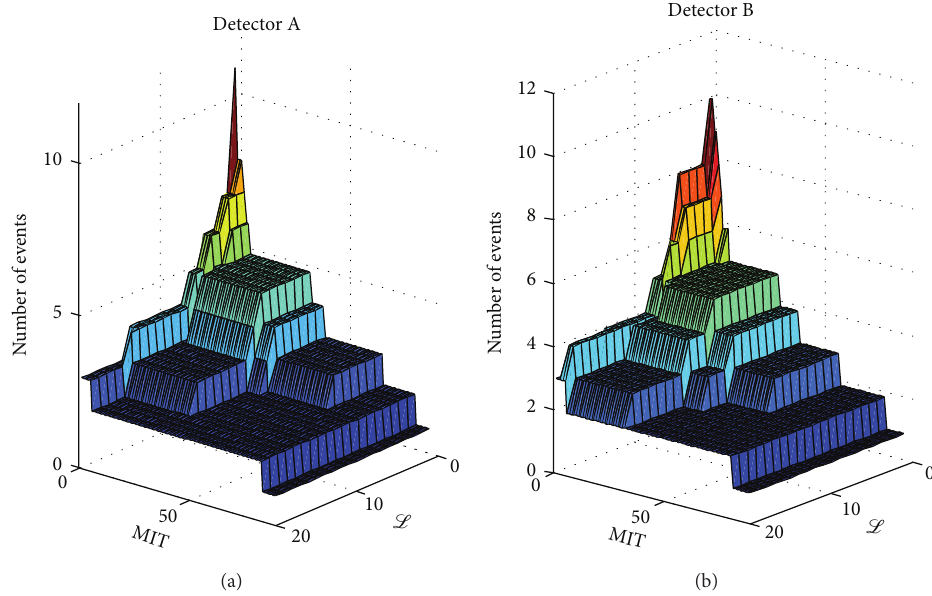
Figure 9: The figure shows the number of events as a function of MIT and L for A and B and associated with the data in the subset depicted in Figure 6. For simplicity, this plot defines a rainy minute as any one-minute spectra that contained at least 128 drops of at least 1mm diameter. Note that despite the fact that these detectors disagreed on the number of events in this interval when simulating a tipping-bucket (see Figure 5), there is great agreement in this parameter space. (The agreement between the two detector event identification is especially striking when MIT and L are not close to the instrument’s